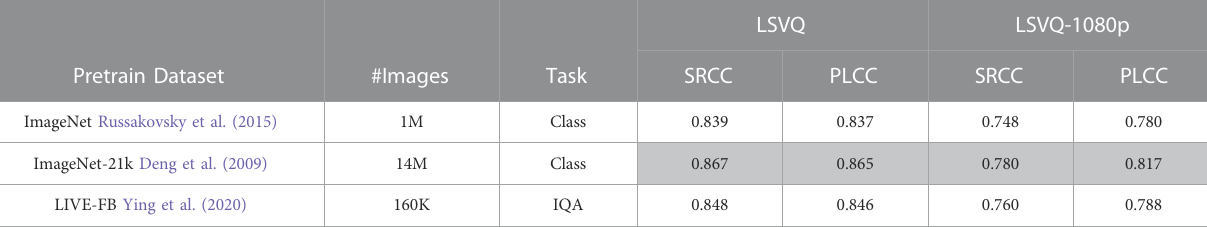
TABLE 6 Results for initializing MRET model from checkpoints pretrained on different image datasests. Our fi nal method is marked in gray.